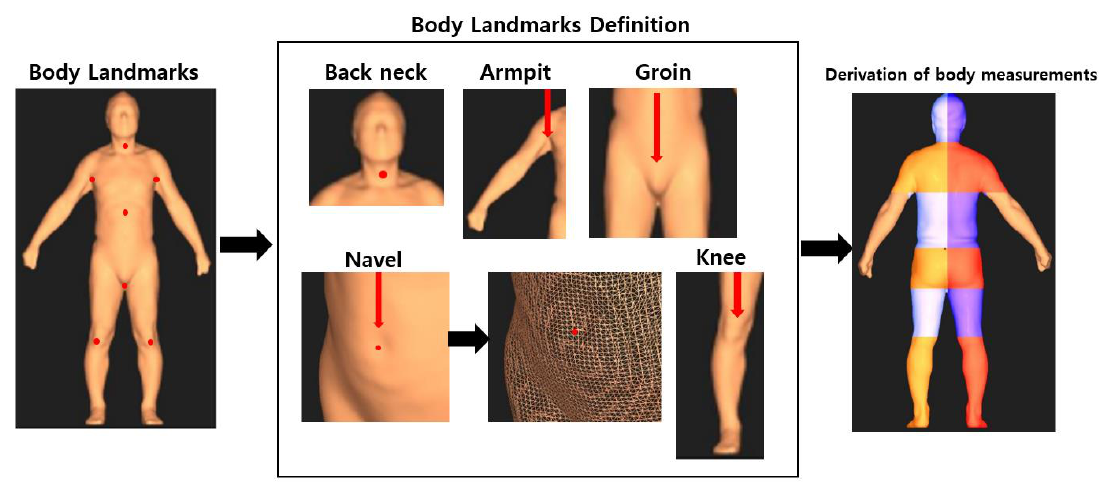
Figure 2. Body point landmark definitions obtained with the 3D scanner .